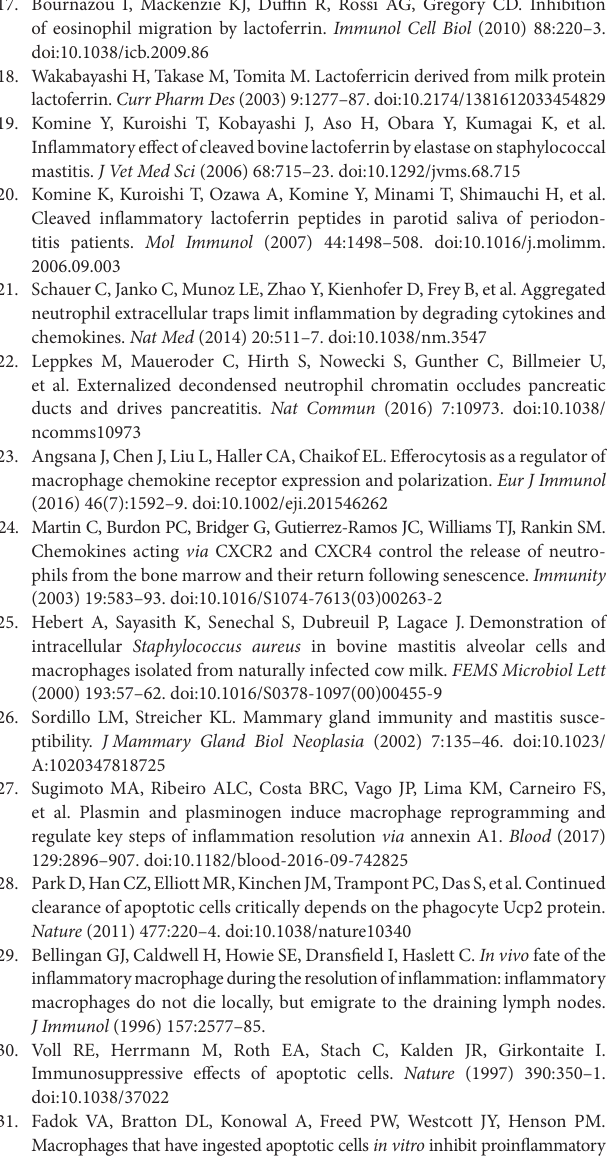
peptides contained in the fragments were identified and aligned in comparison to full-length Lf from various species (l) . Adding quantitative properties of the MS-MS analysis and the known immunogenic epitope in both fragments allowed the determination of the fragment boundaries. The alignment of the various Lf species and the reports by Komine et al. allowed us to predict potentially bioactive peptides present in the 17-kDa fragment of bovine Lf. These peptides were synthesized and purchased from GL Biochem (Shanghai) Ltd. (M) . FigUre s3 | The 17- and 15-kDa fragments of lactoferrin (Lf) are absent in non-resolving and healthy dairy cow milk. Milk samples from none-resolving mastitis-inflicted dairy cows (days 1–4) or healthy (H) cows were separated into soluble and cellular fractions by centrifugation. The cellular fraction was lysed, and the cytoplasmic proteins were recovered. Equal amounts of protein from both fractions were analyzed by Western blotting for Lf. Results